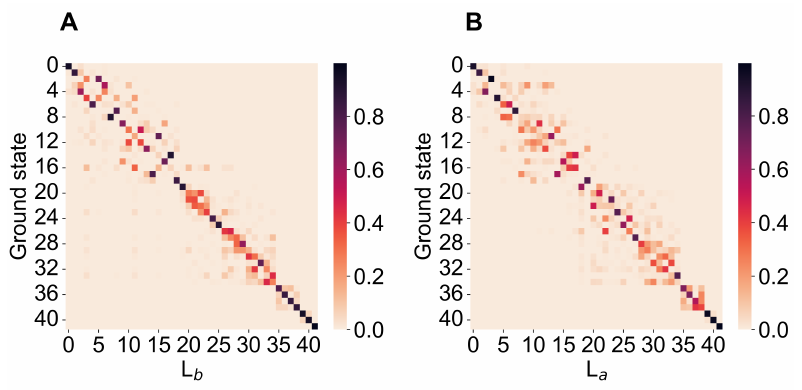
Figure 2. Matrices obtained by the squared elements of the Duschinsky matrix associated to the ground-to-L b -state transition ( A ) and to the ground-to-L a -state transition ( B ). Note that, in both matrices, modes with the same index always have nearly identical frequencies.